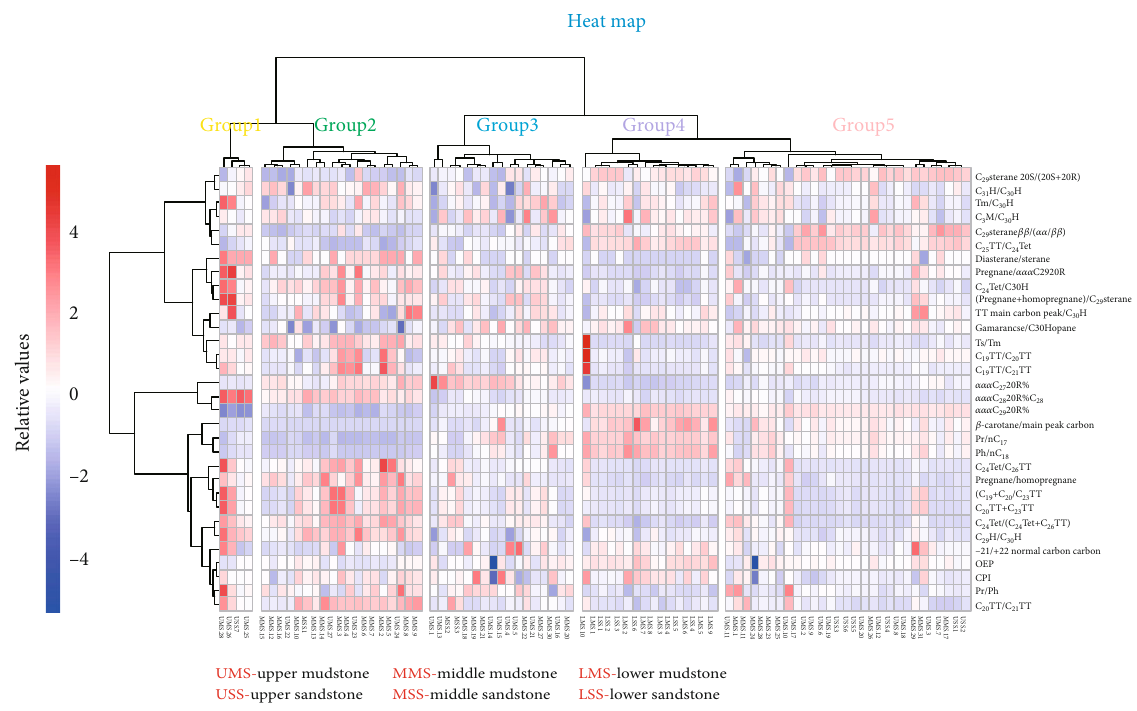
Figure 5: Clustering heat maps of 32 indicators from 85 non-oil samples of the Lucaogou Formation. The Bray – Curtis algorithm was used to conduct the clustering.